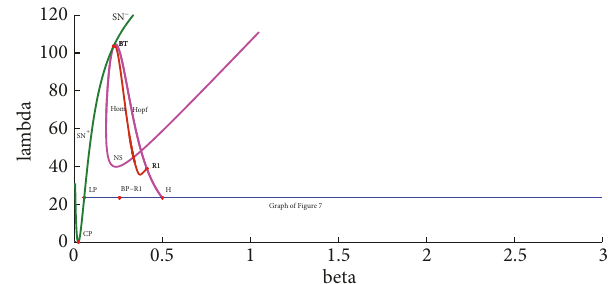
Figure 15: Bifurcation diagram near the BT point. The brown curve shows homoclinic bifurcation, the green curve shows saddle-node bifurcation, and the magenta curve shows the Hopf bifurcation and neutral saddle